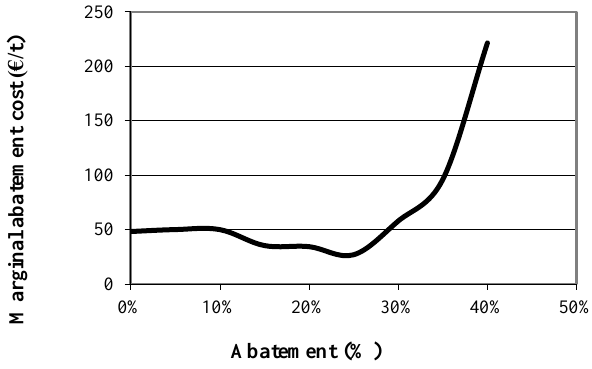
Figure 4. Marginal abatement cost curve of the semi-intensive farm.